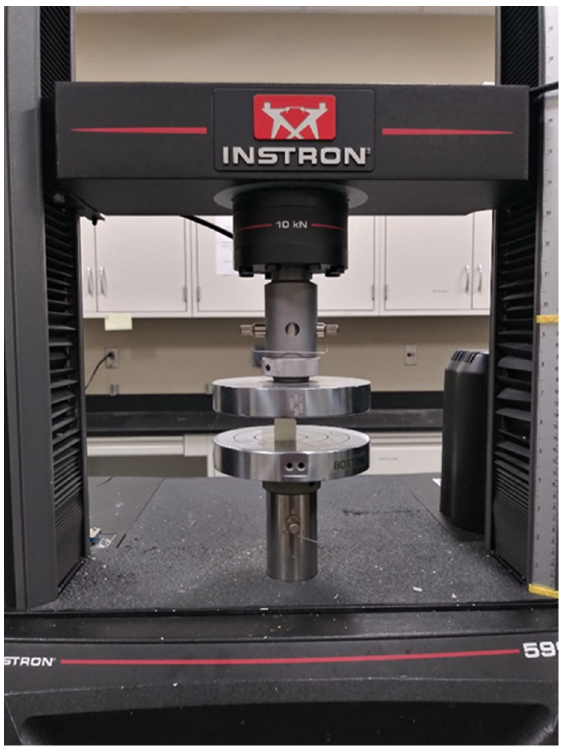
Figure 5. Mechanical testing machine configured for lattice compression.